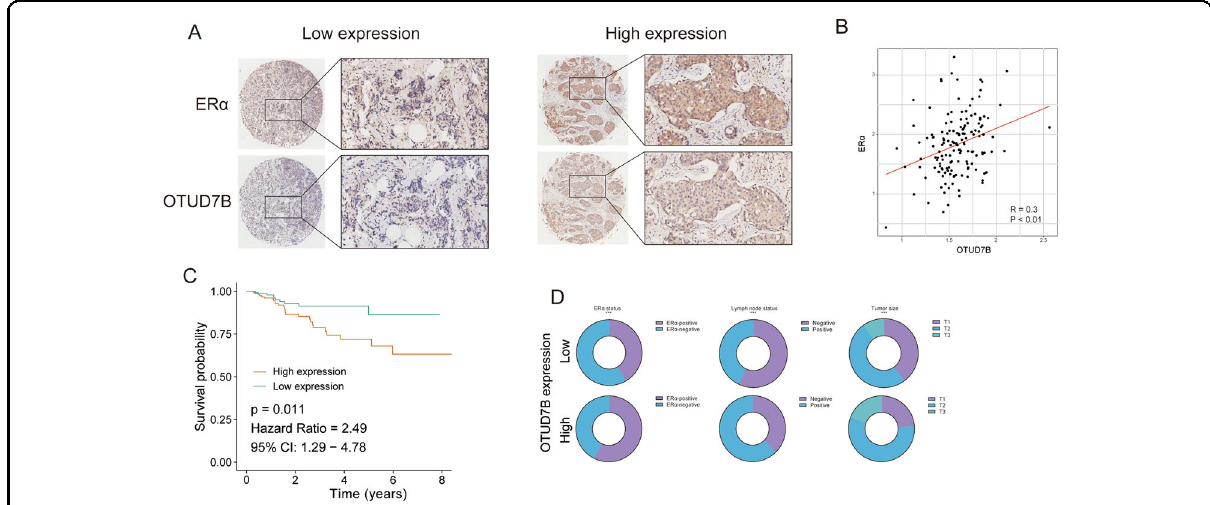
Fig. 3 OTUD7B correlates with ER α protein levels and poor prognosis in human breast cancer samples. Tissue microarray (HBreD140Su04) was obtained from Shanghai Biochip Company Co., Ltd, Shanghai, China. The tissue microarray contained 140 breast cancer specimens. A The typical staining of ER α and OTUD7B in breast cancer specimens. Speci fi c primary antibodies against ER α (Proteintech, China) and OTUD7B (Proteintech, China) were used for IHC. B ER α positively correlated with OTUD7B in breast cancer samples (Pearson correlation). C High expression of OTUD7B was associated with poor prognosis. Cox proportion hazards model was used to understand the signi fi cance between two groups. D OTUD7B expression was associated with the ER α status, lymph-node status, and tumor size. The characteristics were compared between OTUD7B low-/high-groups using chi-square or Fisher ’ s exact tests. * P value < 0.05, ** P value < 0.01, *** P value <